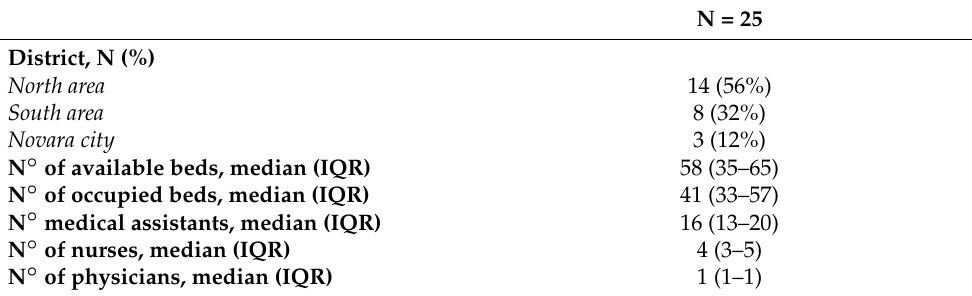
Table 1. Descriptive statistics of LCTF characteristics.